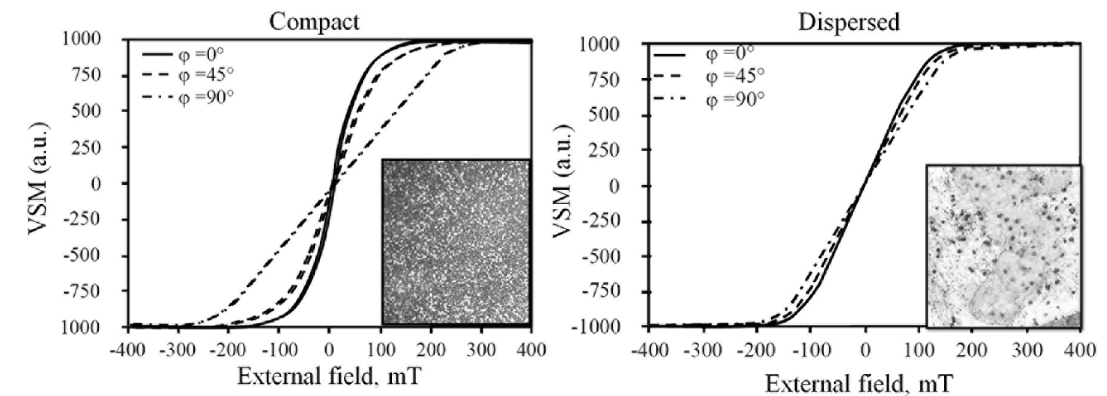
Figure 4. Magnetization curves for compact and dispersed packaging at azimuth 0º, 45º and